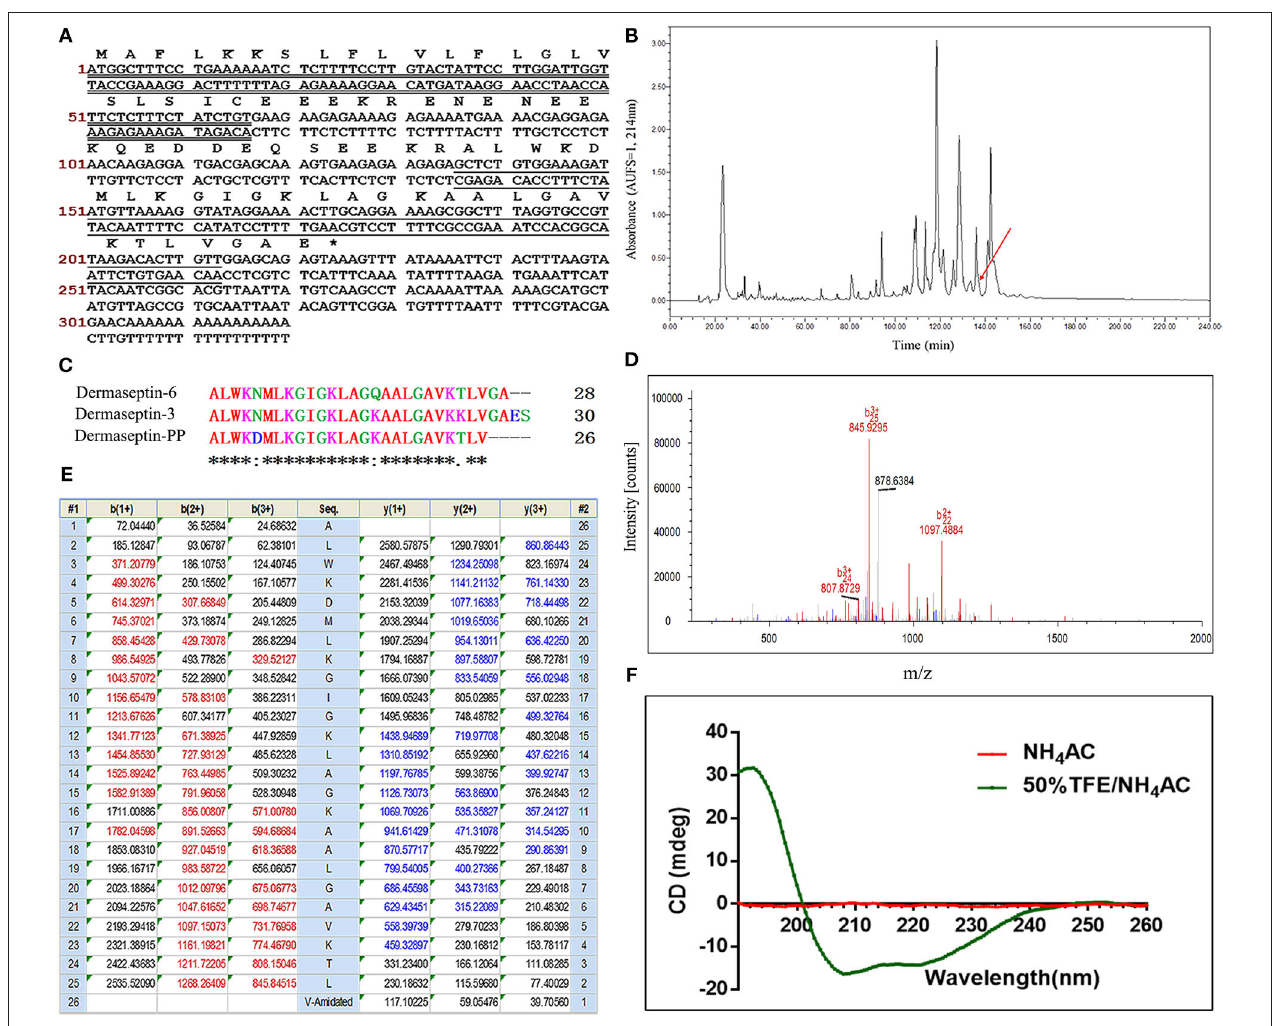
FIGURE 1 | (A) Nucleotide sequence of cDNA cloned from Phyllomedusa palliata skin secretion and the corresponding translated amino acid sequence of the open reading frame of Dermaseptin-PP precursor. The putative signal peptide is double-underlined; the mature peptide is single-underlined; the termination codon is marked by an asterisk. (B) RP-HPLC chromatogram of P. palliata skin secretion at a wavelength of 214nm with a flow rate of 1 mL/min in 240min. The retention time (at 136.5min) of Dermaseptin-PP is indicated by an arrow. (C) Alignment of cDNA deduced mature Dermaseptin-PP sequence with the top 2 non-repetitive similar dermaseptin peptide sequences from BLAST analysis. An “*” represents conserved residues; a “:” represents very similar residues and a “.” indicates similar residues. (D) Annotated LCQ tandem mass (MS/MS) fragmentation spectrum of Dermaseptin-PP. (E) Predicted single-, double-, and triple-charged b- and y-ion series arising from LCQ MS/MS fragmentation of Dermaseptin-PP. The actually observed fragment ions following actual fragmentation are severally colored red (b-ions) and blue (y-ions). (F) The circular dichroism (CD) spectra of pure Dermaseptin-PP in 10mM ammonium acetate (NH 4 Ac) water solution (red line) and 50% 2,2,2-trifluoroethanol (TFE)-10mM NH 4 Ac water solution (green